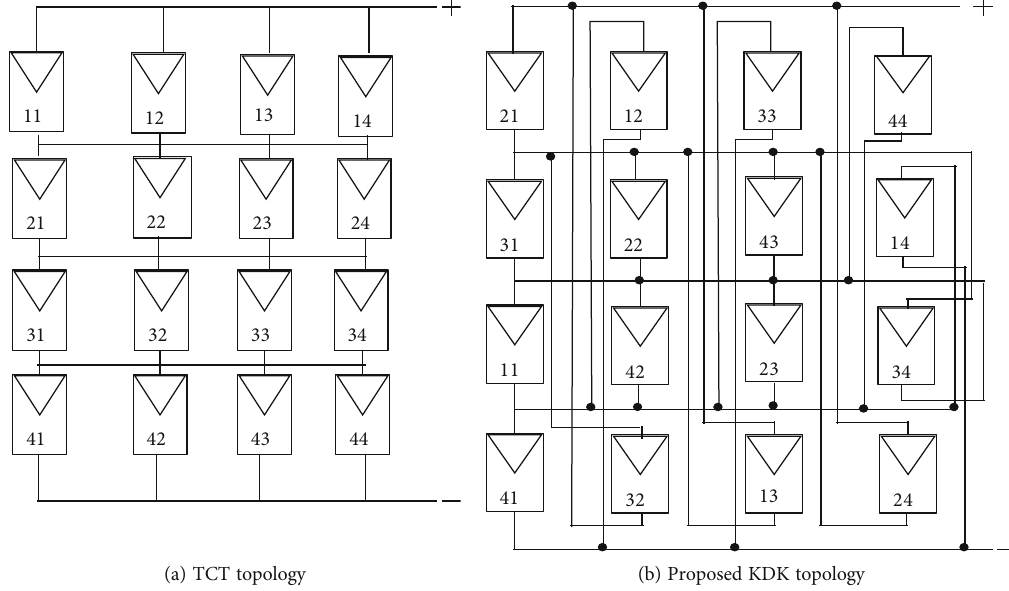
Figure 9: Electrical interconnections of the PV cells in a PV